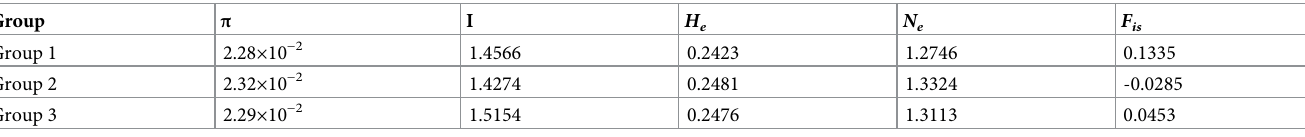
Table 1. Genetic diversity parameters at the group level inferred by